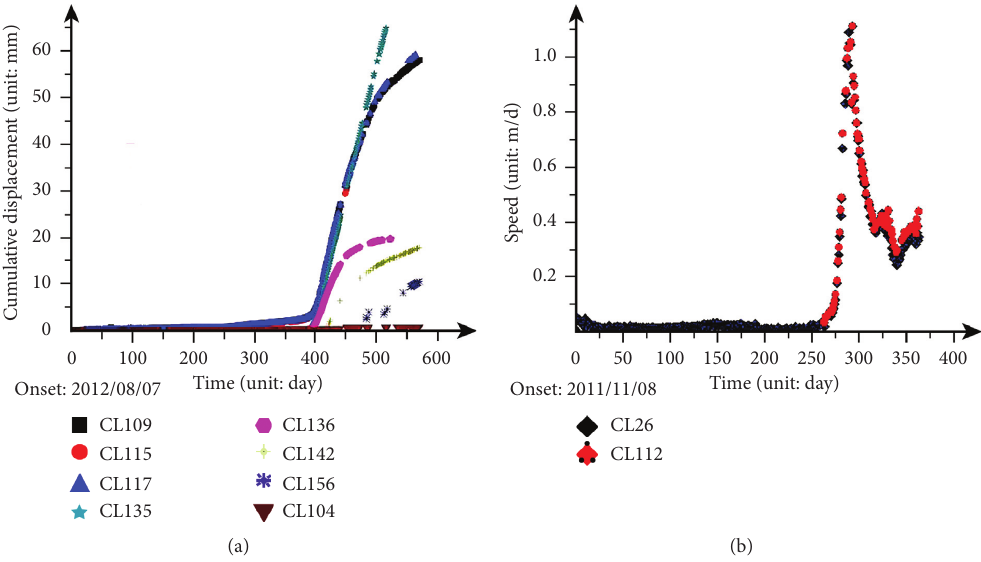
Figure 17: Monitoring data of the points with time. (a) Cumulative displacement. (b)